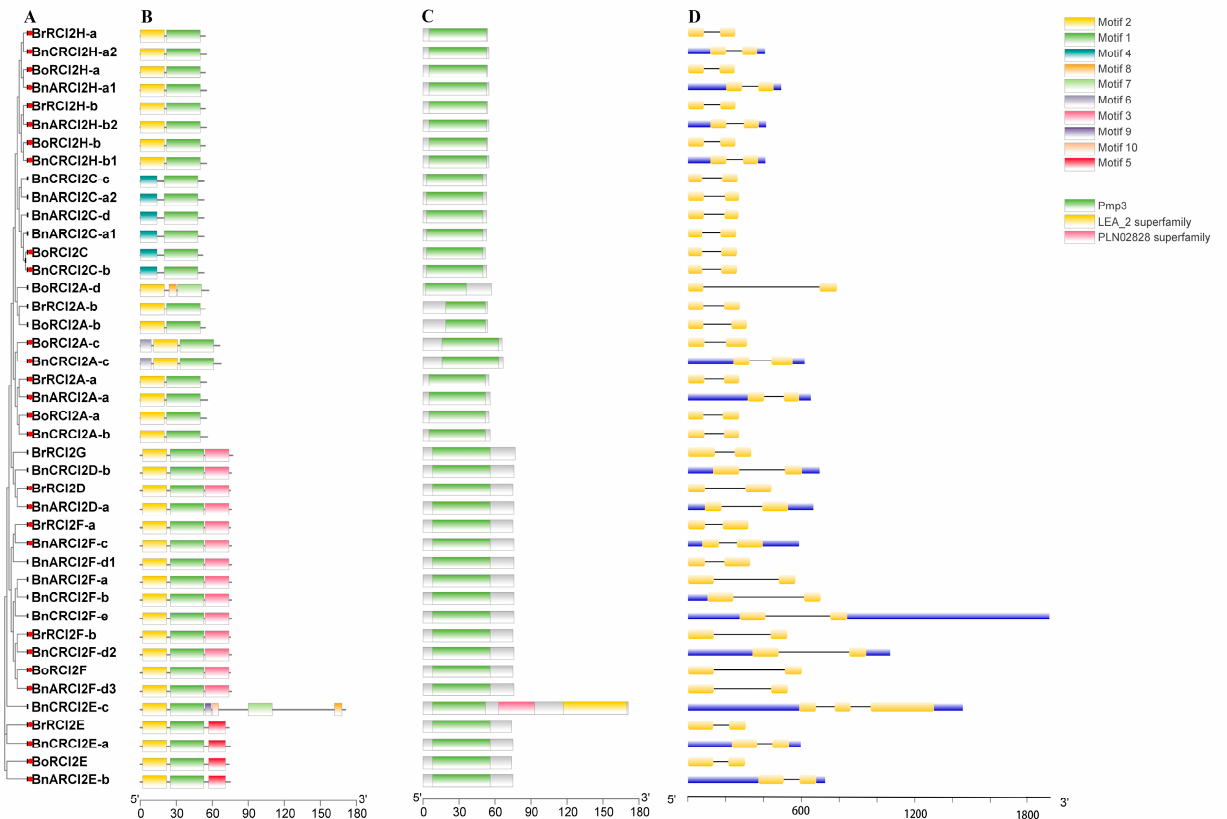
Figure 4. Intron/exon structure and conserved domain and motif overlap characterizations of the RCI2 gene family in B. rapa and B. oleracea , B. napus . The characterizations include phylogenetic tree of the RCI2 gene family ( A ), domain location ( B ), and conserved motif location ( C ), intron/exon structure ( D ). Note: Orthologous gene pairs (14 pairs) between B. napus and its diploid ancestors may have direct evolutionary relationships, marked by the red